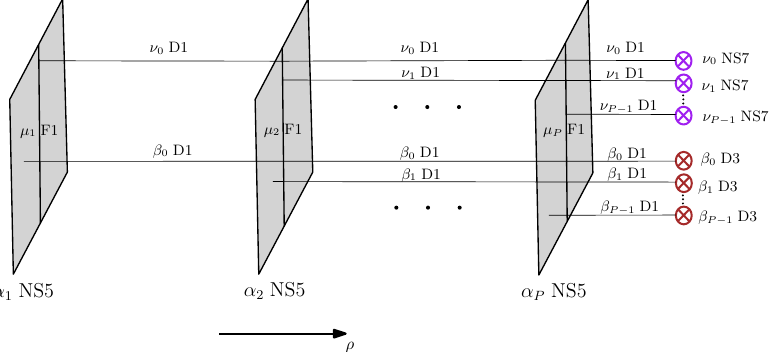
Figure 7 . Hanany-Witten brane set-up of figure 6 after Hanany-Witten